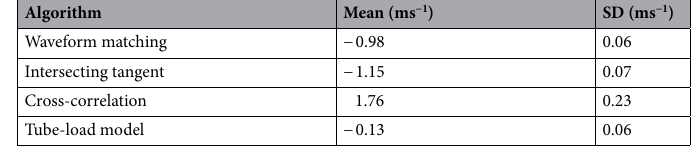
Table 5. Differences between the reference cfPWV given by the 1D model and estimated cfPWV of each algorithm using the carotid and femoral pressure pulse waves from the 1D model.